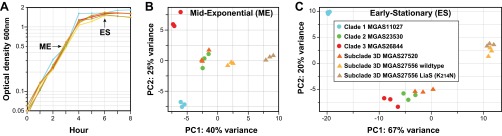
Transcriptome analysis of genetically representative preepidemic and epidemic emm89 strains. RNAseq analysis was done in triplicate for six genetically representative strains. The strain index provided in panel C applies to all of the panels. (A) Growth curves. The graph shows the averages of growth curves analyzed in triplicate. The growth curves were closely similar for all strains. Cells were harvested for RNA isolation at mid-exponential growth (ME = optical density at 600 nm [OD600] of 0.5) and early stationary growth (ES = 2 h post-exponential phase). (B and C) Principal component analyses. Illustrated are transcriptional variances among the strains expressed as the primary and secondary principal components, the two largest unrelated variances in the data. Strain replicates cluster, illustrating good reproducibility.